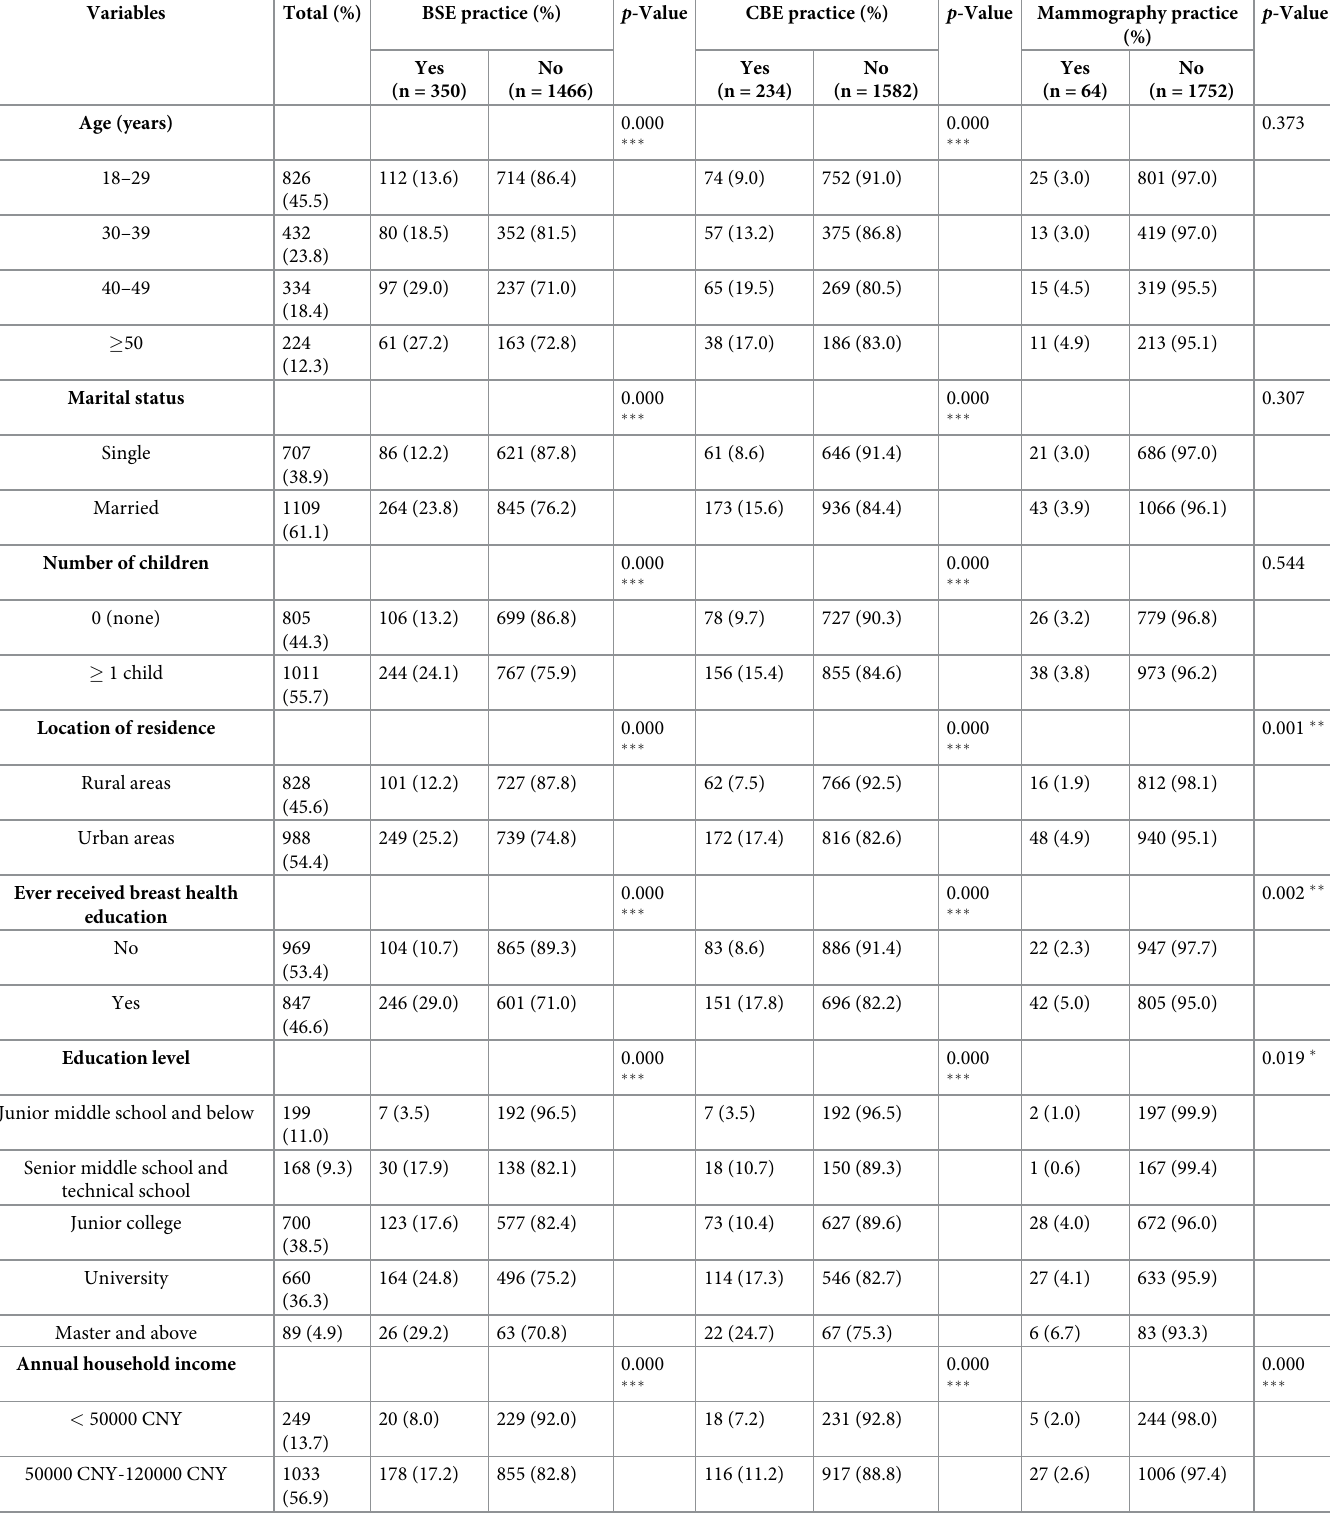
Table 1. Demographic information and breast cancer screening practices (n =